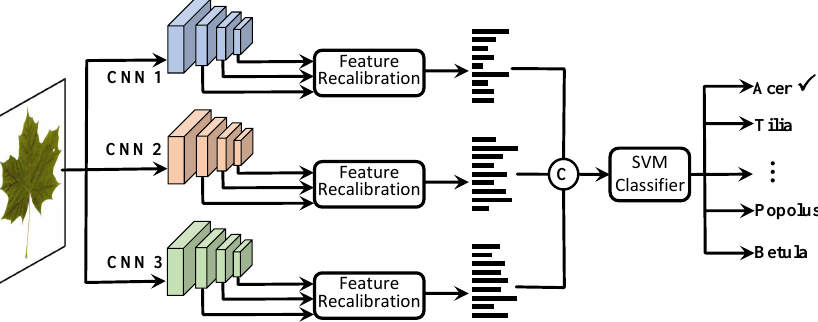
Figure 2. Our plant leaf image feature extraction and classification